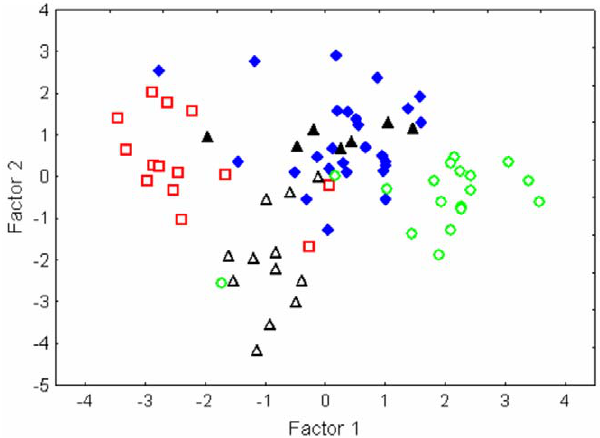
Figure 4. Plot of canonical scores from discriminant function analysis on echolocation and wing parameters. The five groups correspond to Figure 2 and squares=Group 3, open triangles=Group 1, closed triangles=Group 2, diamonds=Group 5 and circles=Group 4.